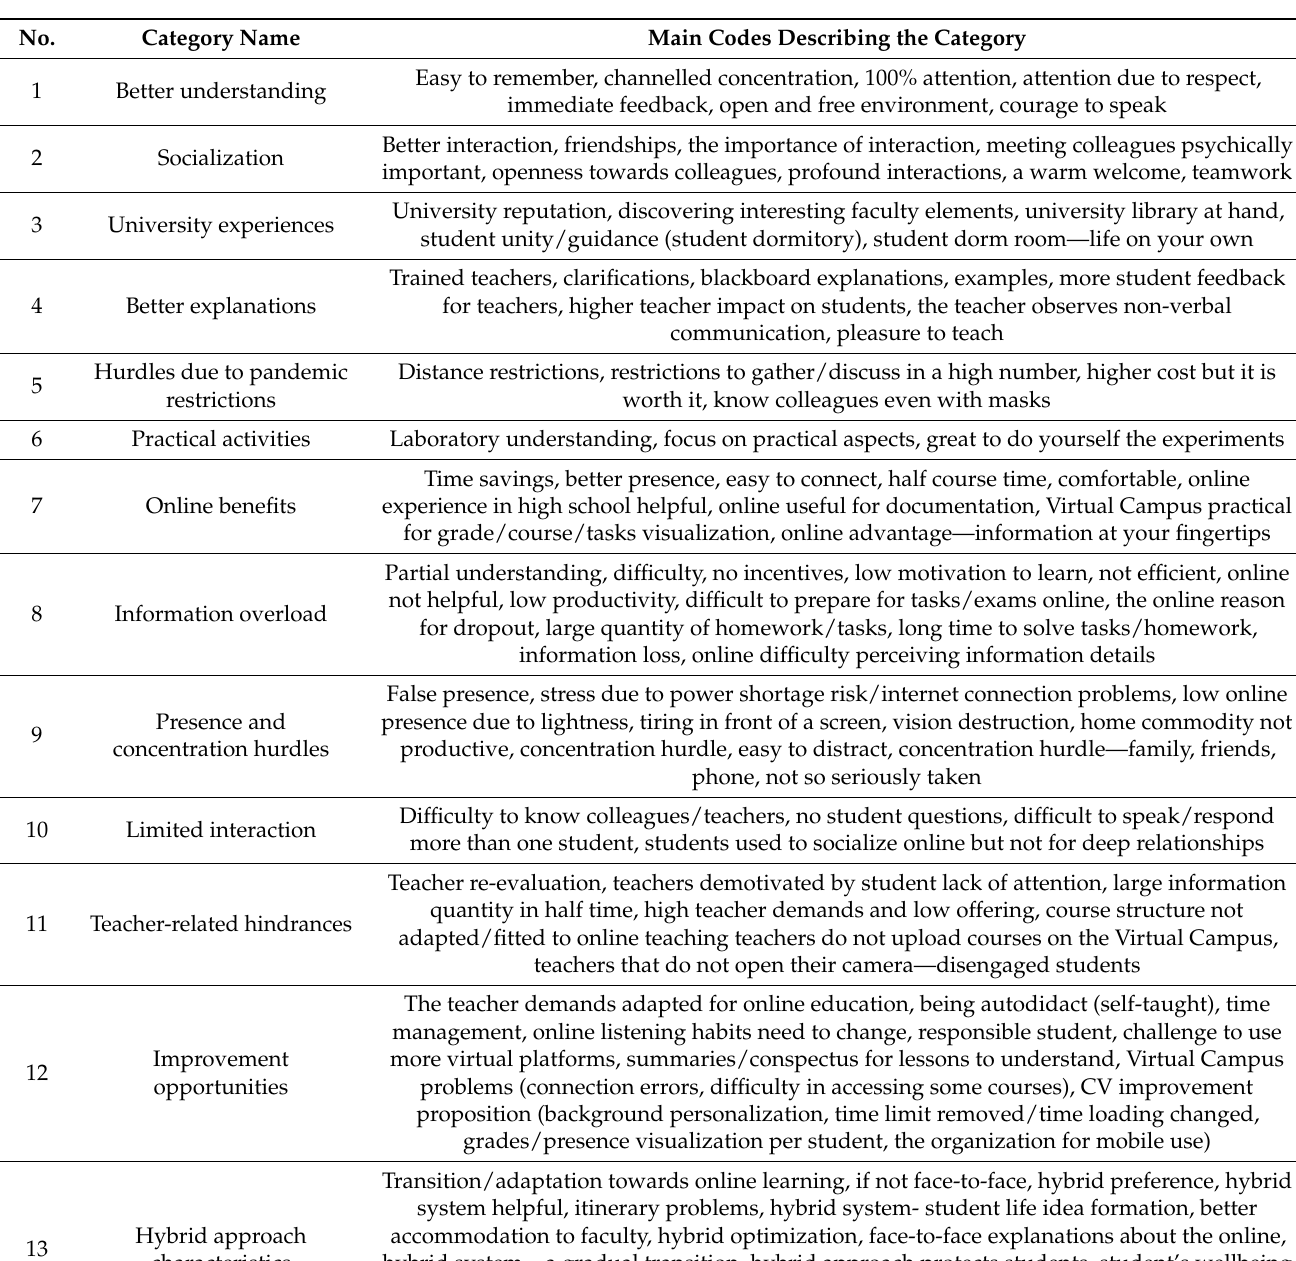
Table 2. The 13 categories formed in the axial coding phase of the